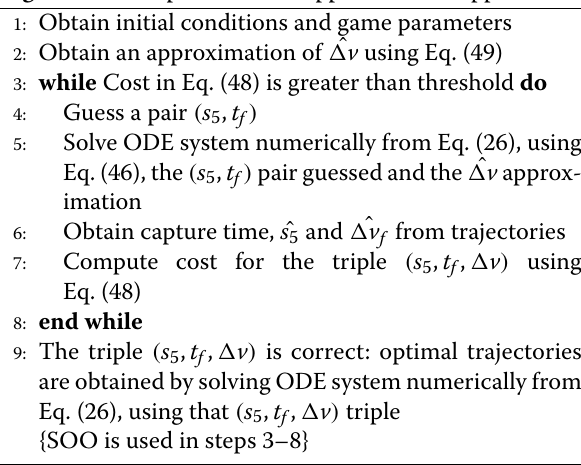
ˆ (cid:12) v approximation approach